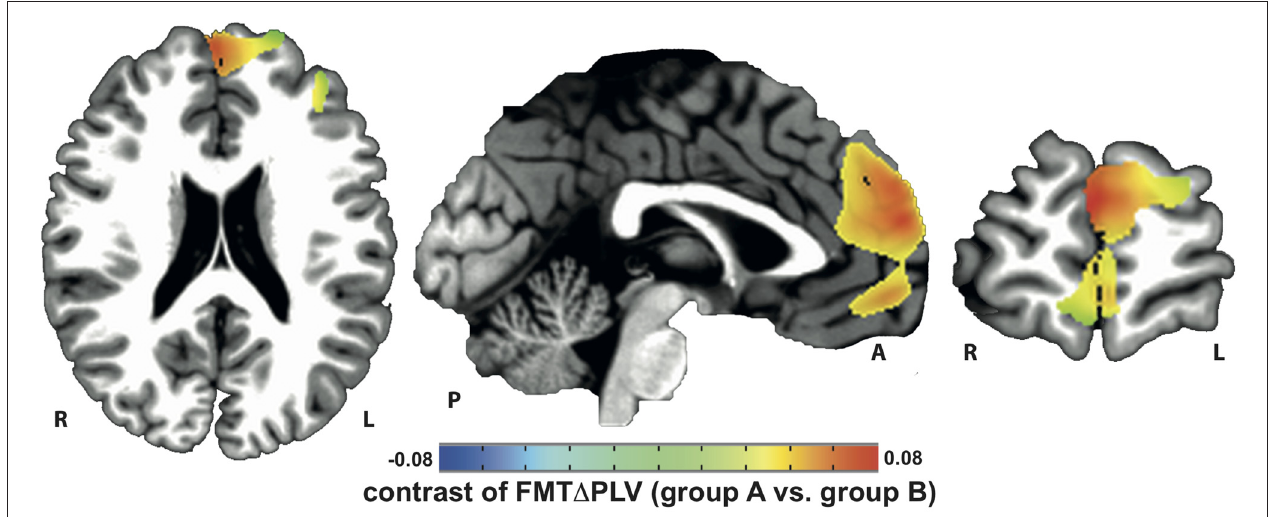
FIGURE 2 | Increase in tACS-dependent phase-locked brain activity was identified in frontal brain areas that included the prefrontal and anterior cingulate cortex (PFC/ACC) previously shown to be important for working memory (WM) task execution